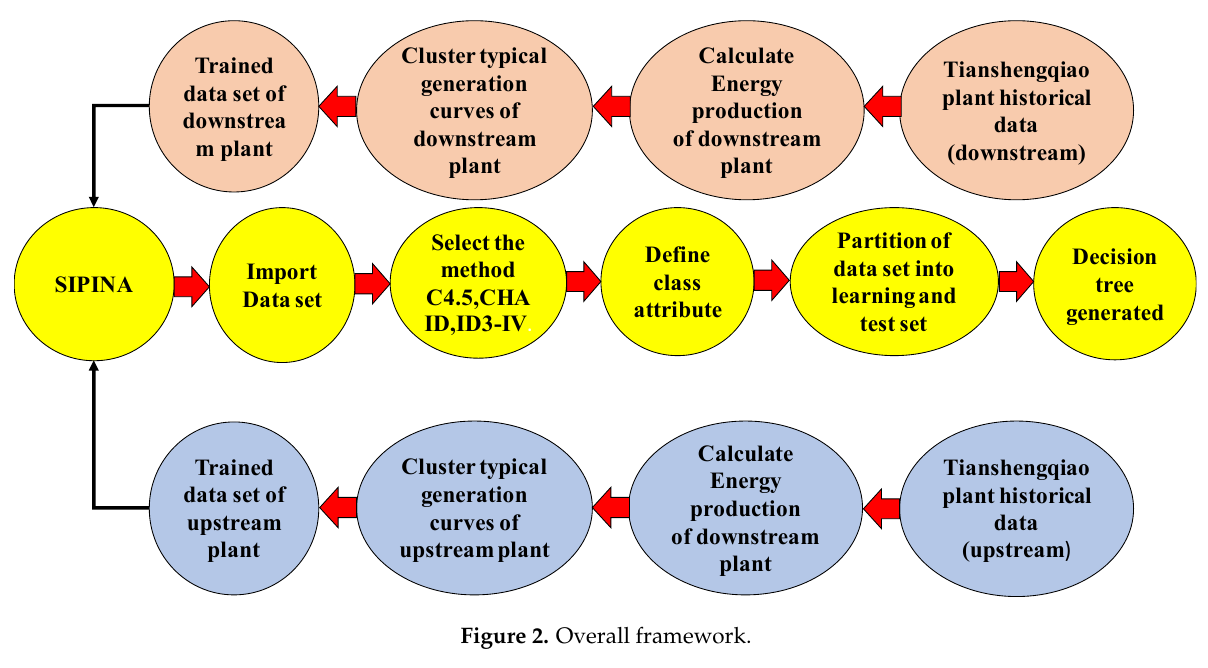
Figure 2. Overall framework.